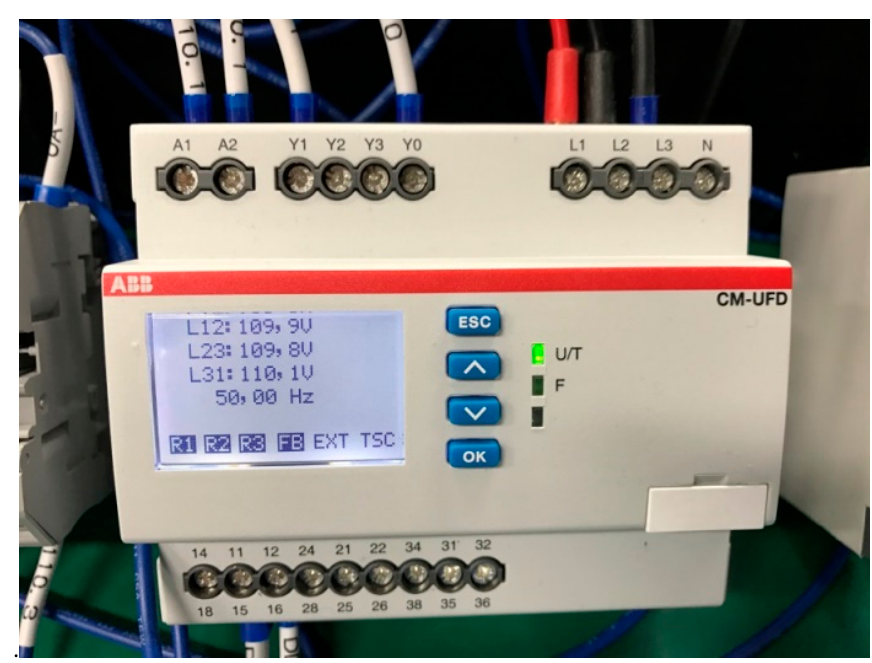
Figure 27. Normal operation of relay.